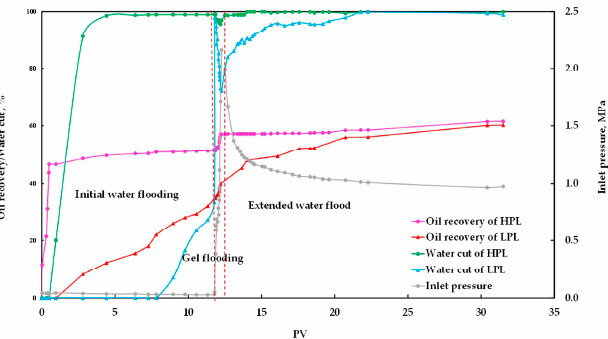
Figure 5. The production index curve of the gel flooding experiment. Table 4. The statistics of the production indexes of the gel flooding experiment.